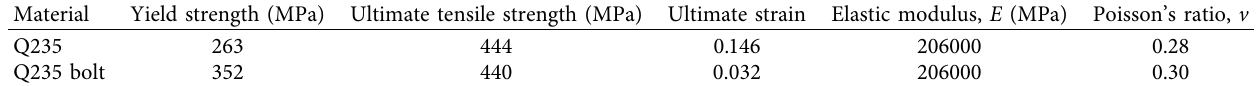
Table 2: Mechanical properties of the angle steel and bolt.